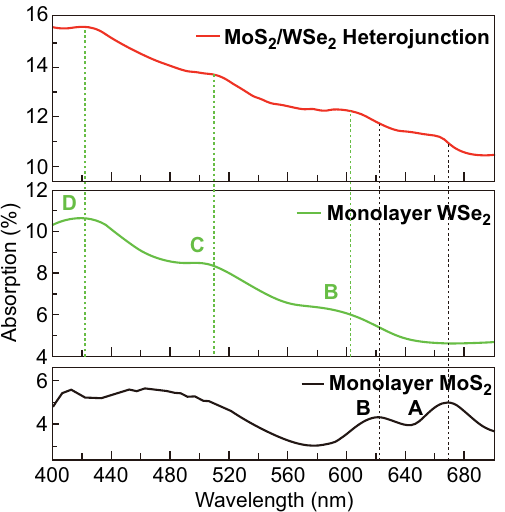
Fig. 4 Absorption spectra of MoS 2 /WSe 2 heterojunction (red curve), monolayer WSe 2 (green curve) and monolayer MoS 2 (black curve). (Color figure